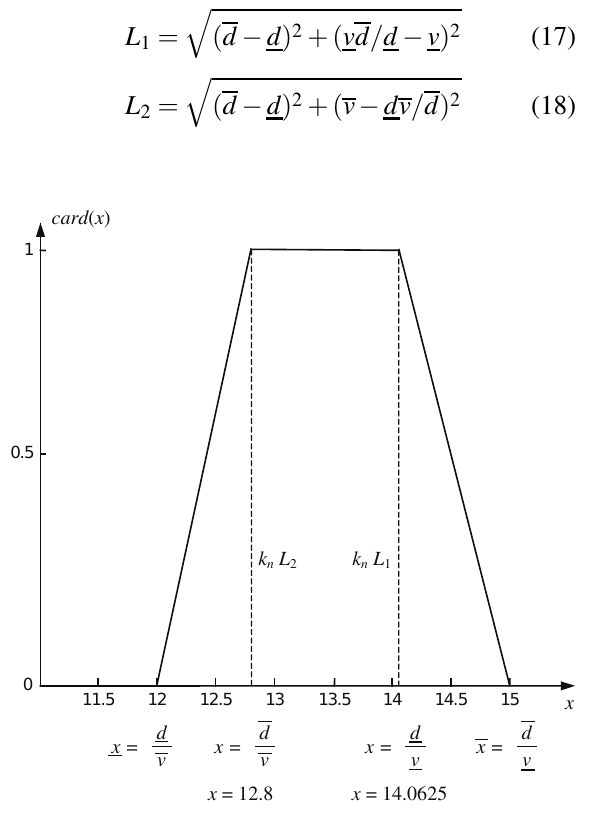
Fig. 6. Distribution of the normalised cardinality card ( x ) of possible results x ∈ [ x , x ] = [ 12 , 15 ] of the IPVs division d / v from Example 1, k n – normalising